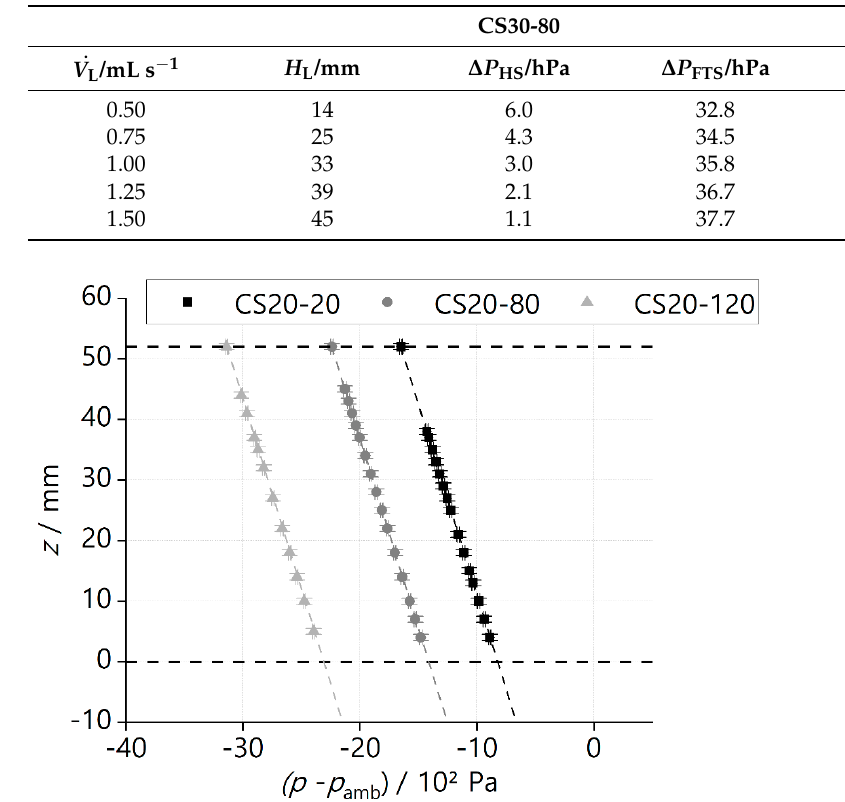
Figure 8. Experimental data (symbols) and calculated hydrostatic head (dotted lines, Equation (14)) from phase − separation experiment at different flow rates for samples with 20 wt% of solid loading. Details corresponding to each data point are given in Tables 4–6. The vertical error bar for height measurement z is ± 0.5 mm and the horizontal error bar for pressure difference ( p − p amb ) is ± 0.1 hPa.